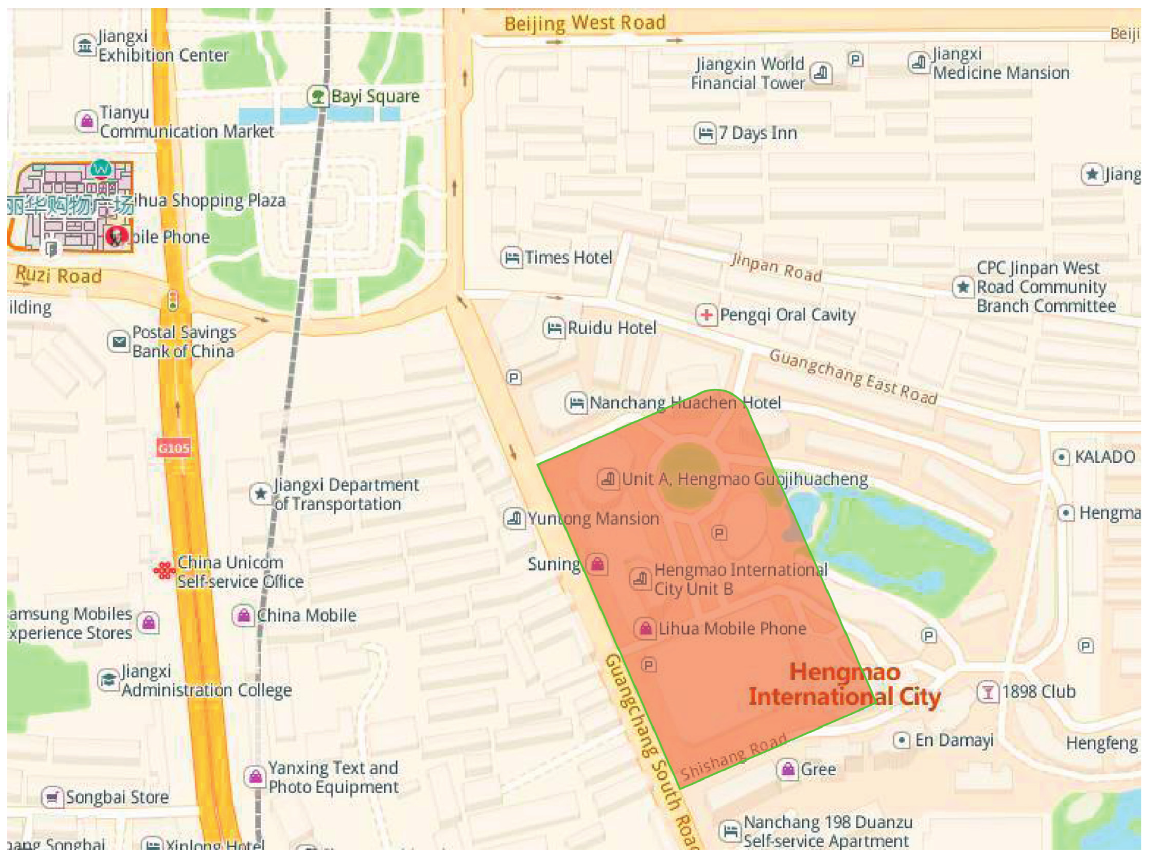
Figure 4: Survey